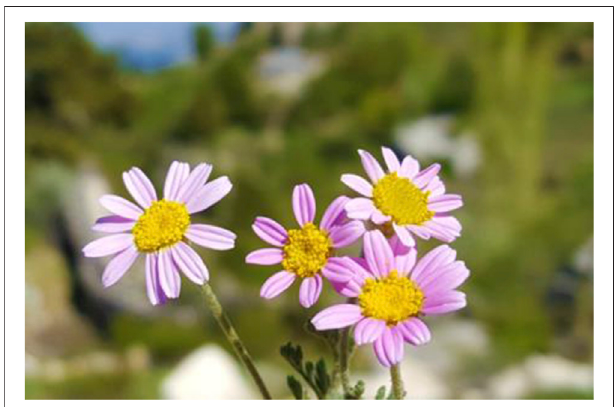
FIGURE 5 | Habit view of endemic Anthemis rosea subsp. carnea